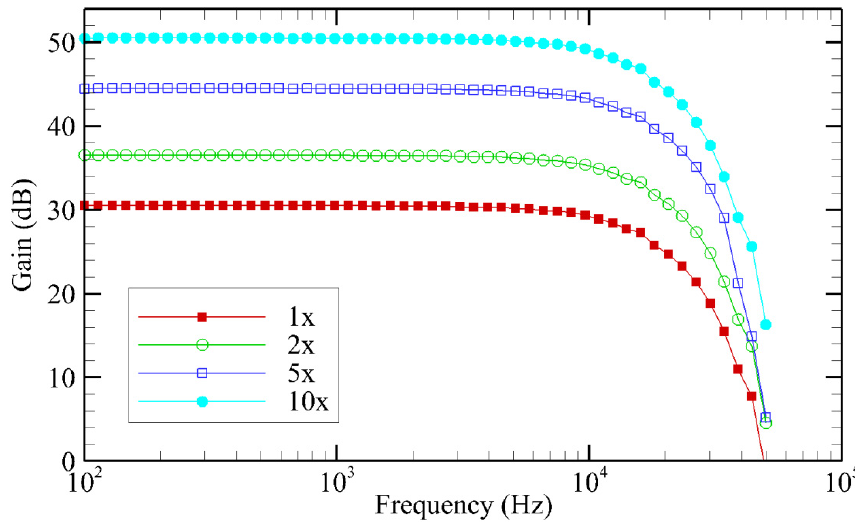
Figure 9. Underwater Sound Recorder system average frequency response for each gain